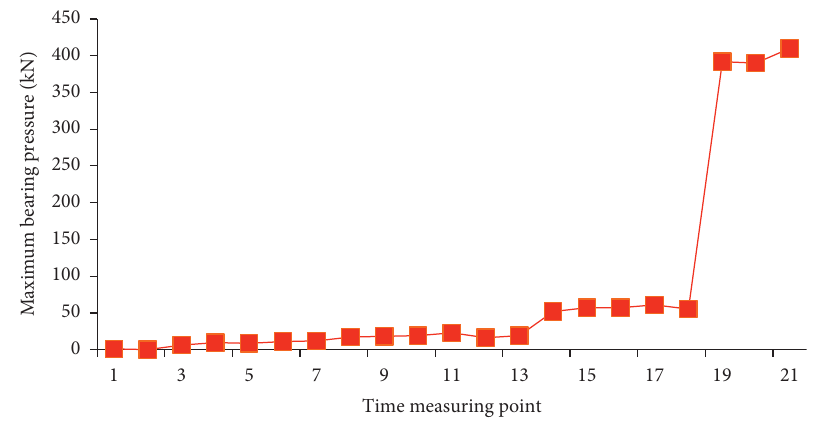
Figure 24: Stress curve of the 22nd measuring point on the main